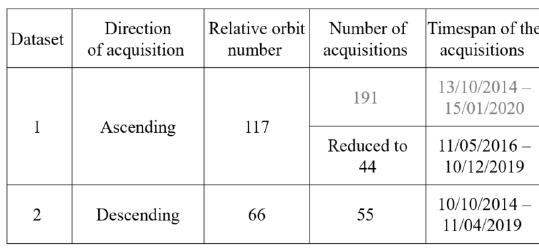
Table 1: Sentinel-1 datasets and acquisition